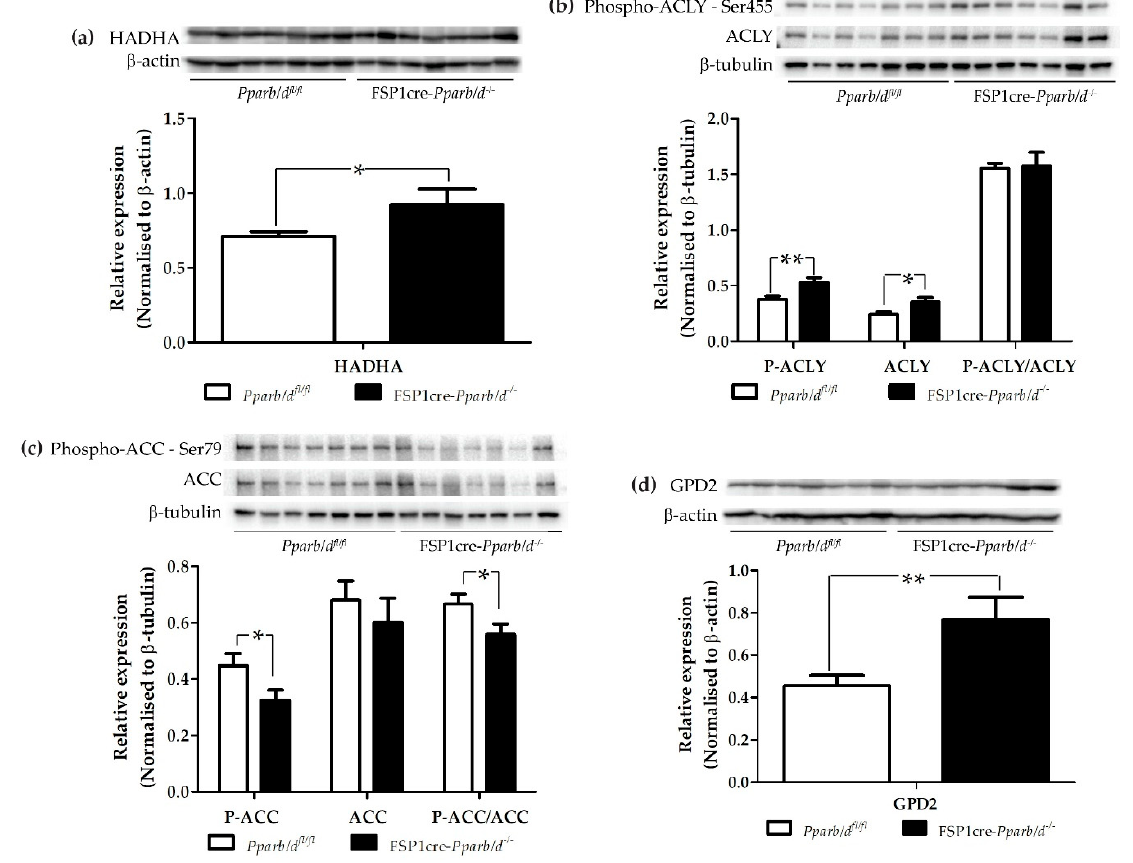
Figure 7. Expression levels of proteins in fatty acid β -oxidation, fatty acid synthesis, and triglyceride synthesis pathways. Immunoblot analysis of indicated proteins in the liver of P2 Pparb / d fl / fl and FSP1cre- Pparb / d − / − mice. Representative blots from 7 mice (biological replicates) for each genotype and